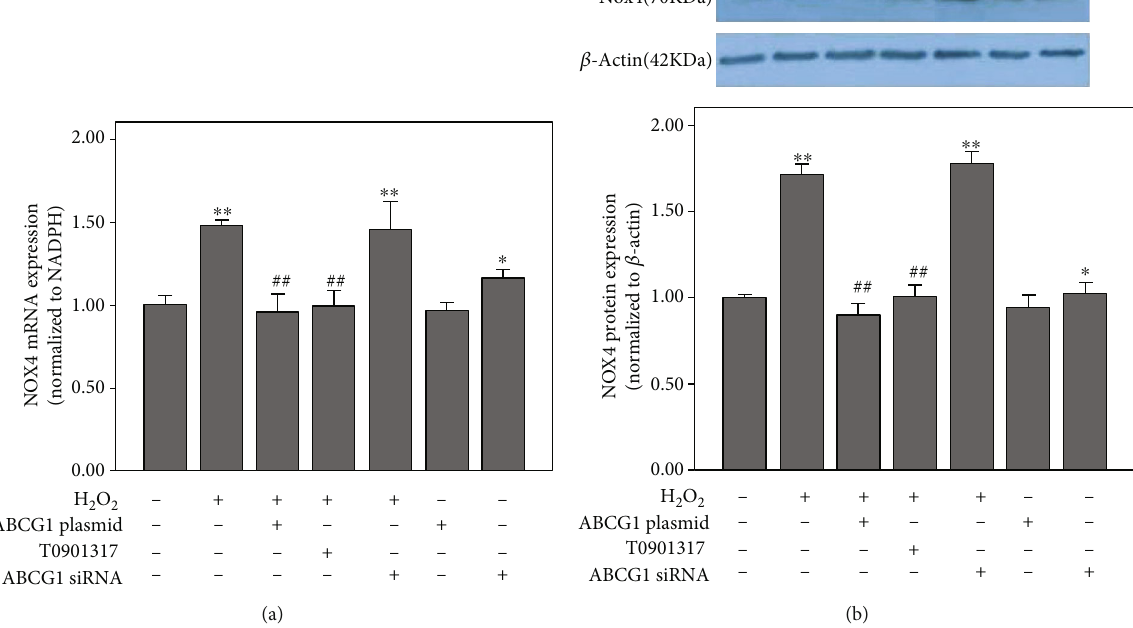
Figure 3: E ff ect of ABCG1 on H O -induced expression of Nox4 in HUAECs. HUAECs were transfected with the speci fi c ABCG1 siRNA or 2 2 ABCG1 overexpression plasmid or preincubated with T0901317 and then treated with H expressions of Nox4 (a) mRNA and (b) protein were measured by real-time PCR and western blotting, respectively. Data shown are means ± SD ( n = 3 ). ∗ P < 0 : 05 , ∗∗ P < 0 : 001 vs. controls; ## P < 0 : 001 vs. HUAECs incubated with H